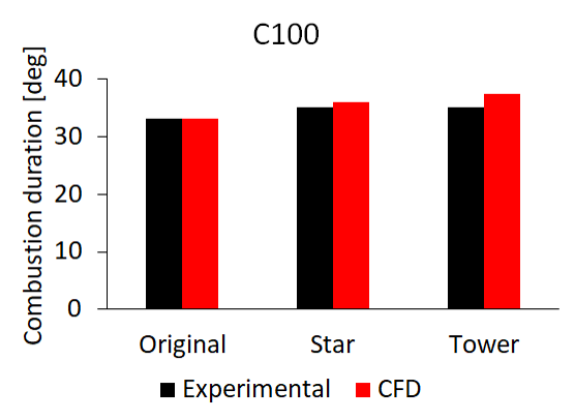
Figure 15. Comparison between the computed and experimental combustion durations for the C100 operating point and the three different piston